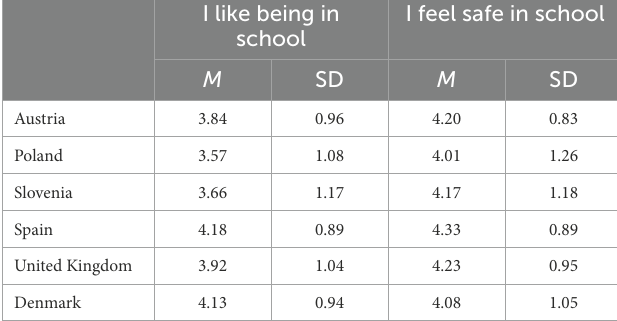
TABLE 4 School satisfaction and feeling of safety (mean